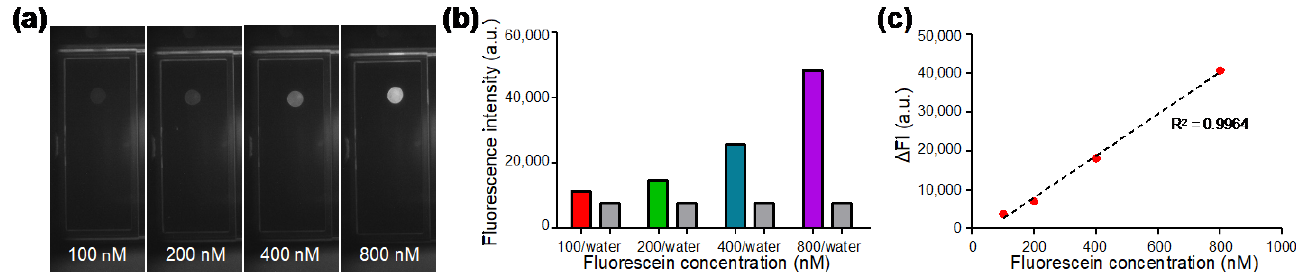
Figure 3. Characterization of the optical module with serially diluted fluorescein solutions. ( a ) Fluorescence images of fluorescein solution droplets at different concentrations captured by the optical module. ( b ) Fluorescence intensity of water droplets and fluorescent droplets at various concentrations. ( c ) Standard calibration curve for fluorescein concentration between 100 nM and 800 nM showing desirable linearity for qPCR.